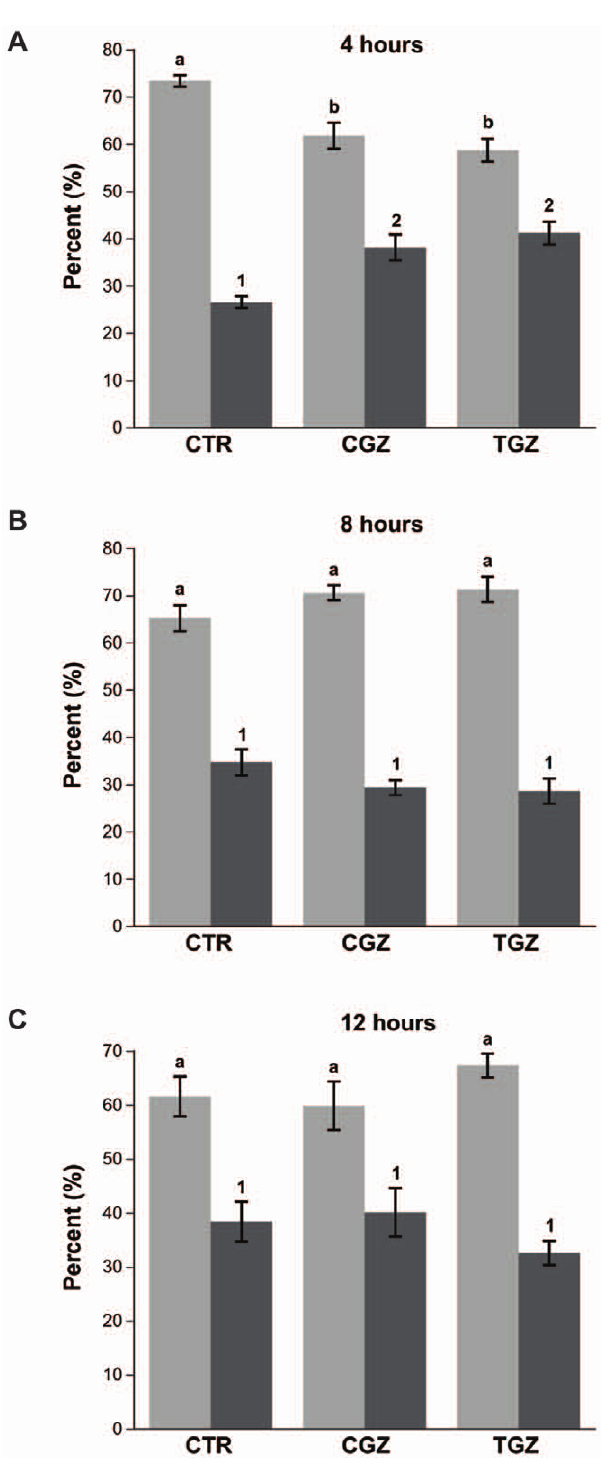
Figure 6. Annexin V assay to detect apoptosis in Ovcar3 cells. Ovcar3 cells were serum starved for 24 hours and treated with vehicle control (DMSO) or 10 m M of CGZ or TGZ for ( A ) 4 hours, ( B ) 8 hours, or ( C ) 12 hours. Results are the means 6 SEM of 3 measurements from three individual experiments. Light gray bars represent viable cells; dark gray bars represent cells undergoing early and late apoptosis as well as those that are dead. Bars that do not share a letter or number designation are significantly different ( p , 0.05).